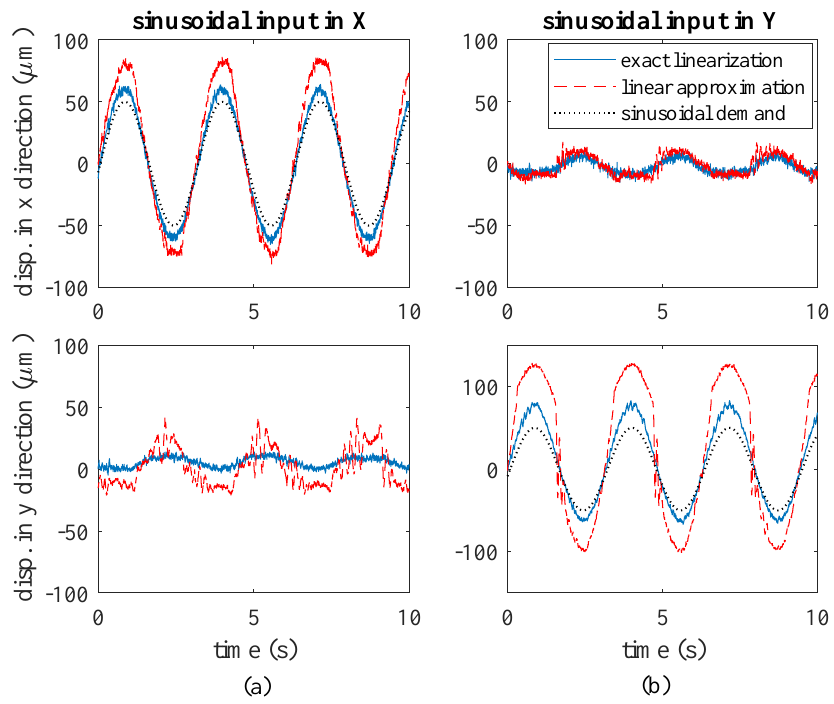
Figure 13. Displacement response of the non-rotating thin-walled rotor due to ( a ) sinusoidal demand input in X direction ( b ) sinusoidal demand input in Y